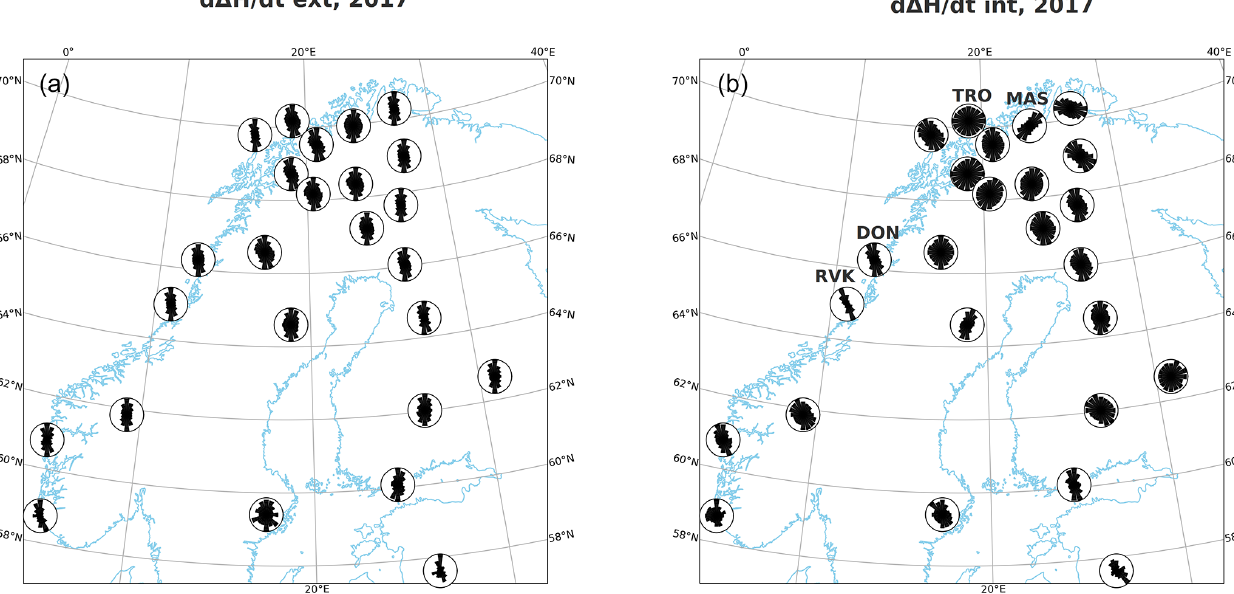
Figure 5. Directional distribution of external (a) and internal (b) d (cid:49) H / d t at IMAGE stations in 2017 when | d (cid:49) H / d t | > 1nTs − 1